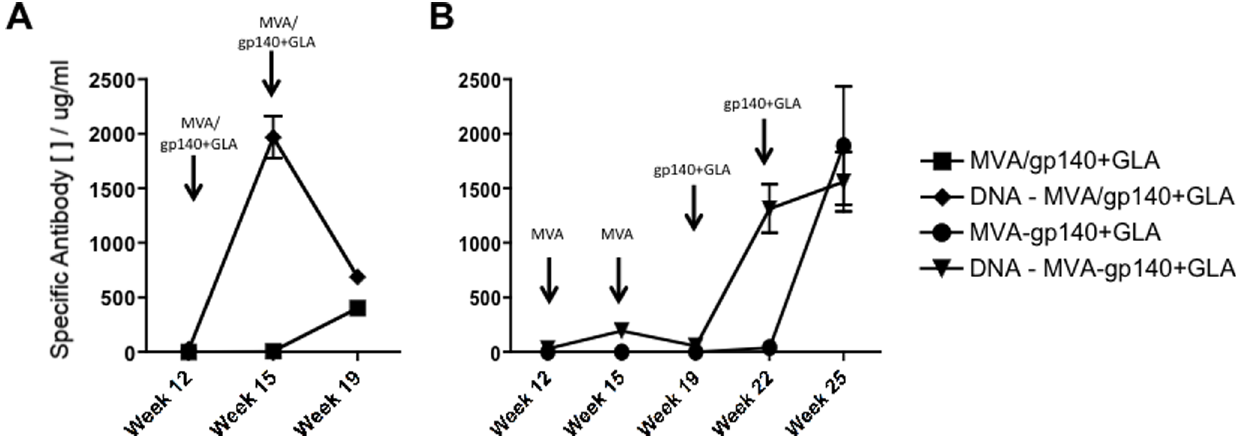
Figure 3. Anamnestic humoral responses after plasmid DNA vaccination. ( A ) Mice that had been previously inoculated three times with plasmid DNA expressing the CN54gp140 Env transgene elicited a memory B cell population that differentiated into antigen-specific antibody secreting cells after a single MVA/gp140 + GLA vaccination. ( B ) MVA alone was also able to re-stimulate this memory population of B cells and this was again further boosted by subsequent inoculations of the recombinant adjuvanted antigen CN54gp140. Antigen-specific IgG antibody was assessed by an immunoglobulin ELISA and concentrations are shown in m g/ml ( + / 2 SEM).